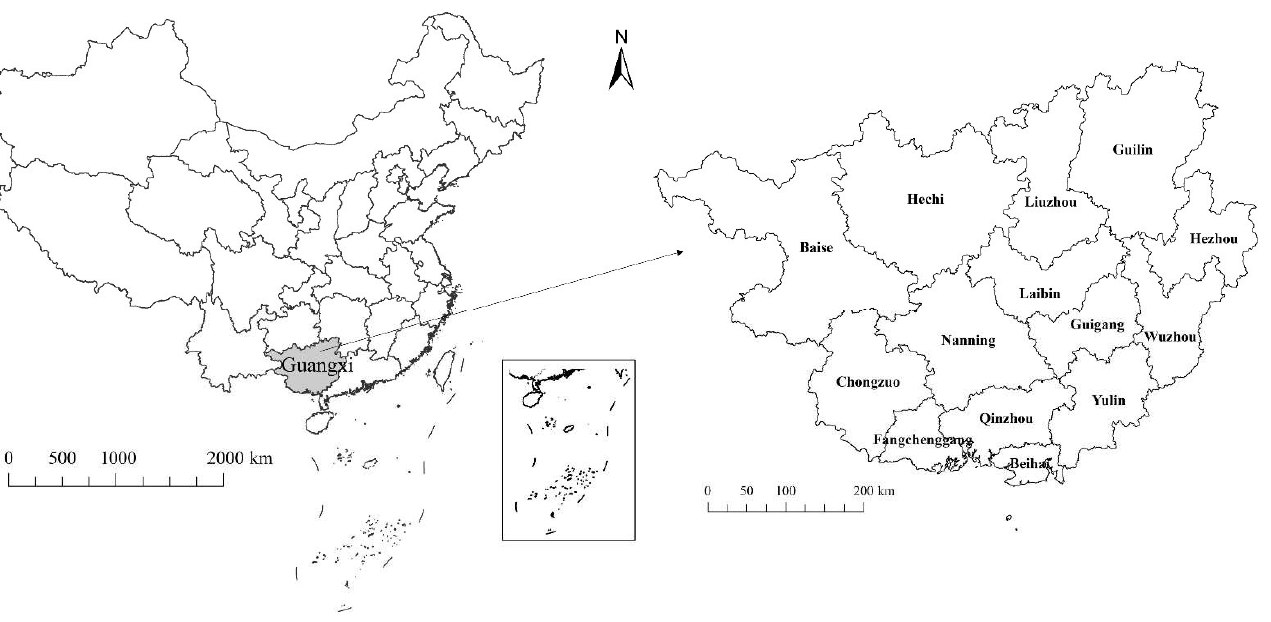
Figure 1. Location of the study